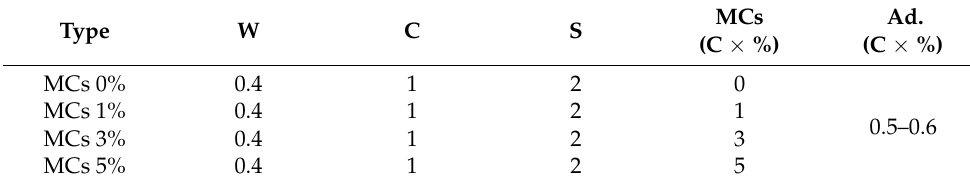
Figure 5. Shape of MCs (SEM): ( a ) original MCs ( × 500); ( b ) MCs inside mortar ( × 500); ( c ) broken MCs ( × 500); ( d ) membrane thickness of MCs ( × 20,000). Table 2. Mix ratio of mortar.